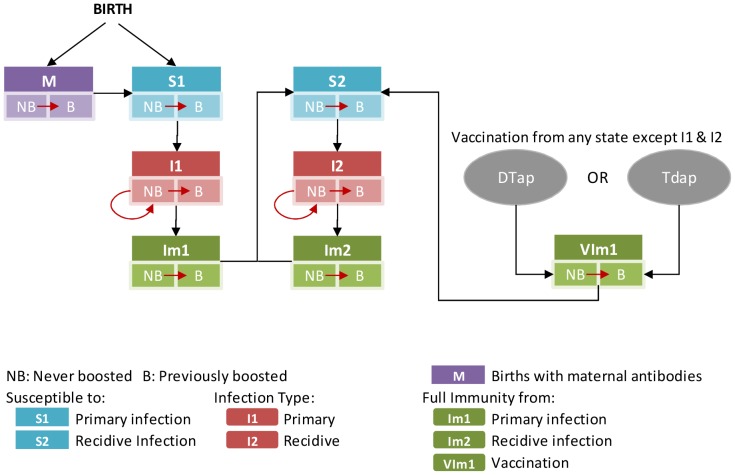
Transmission Model.